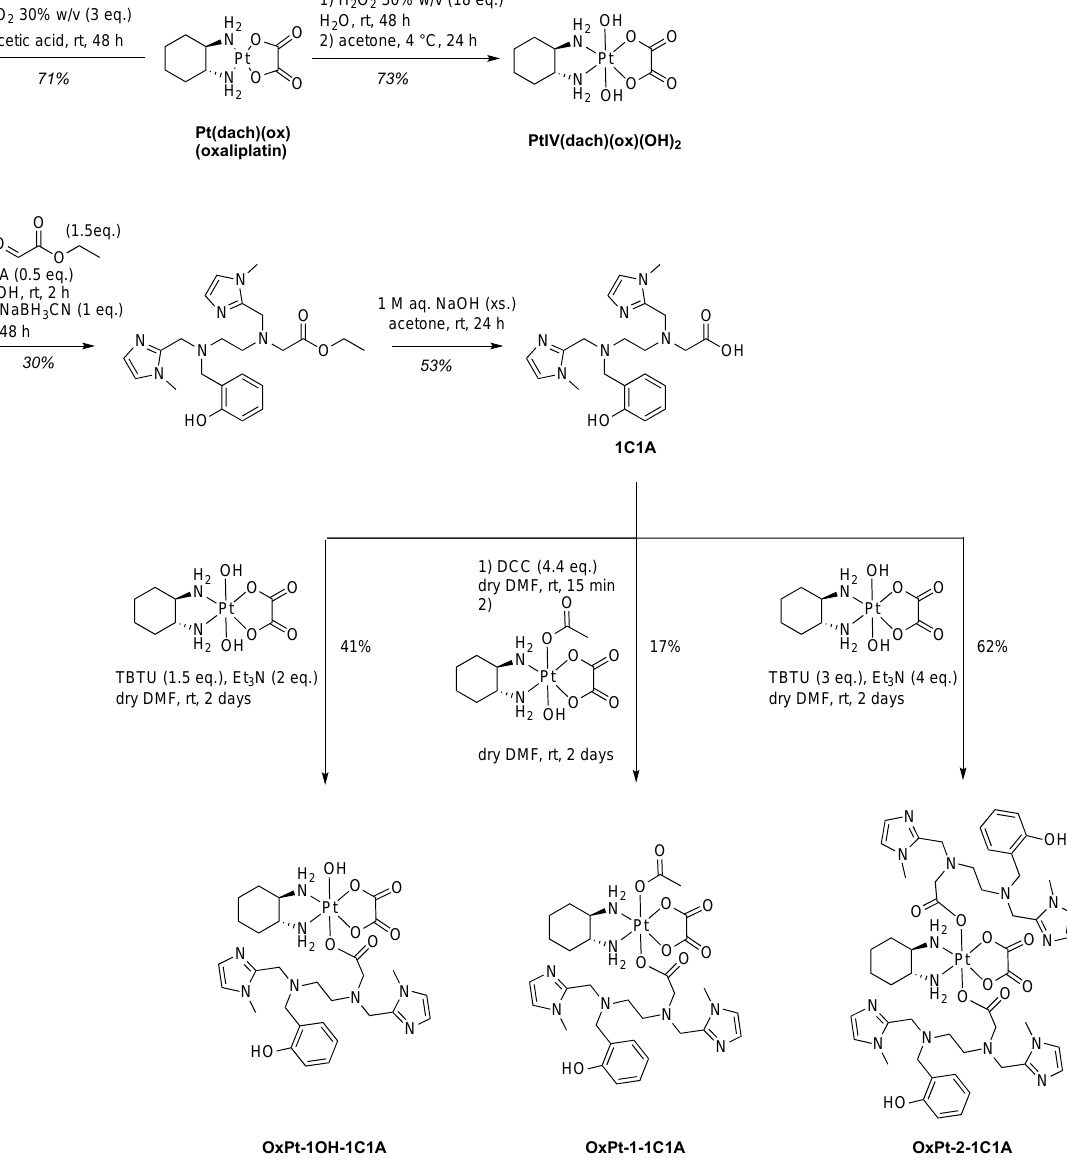
Scheme 1. Synthesis of the 1C1A ligand and the three Pt(IV) conjugates before Mn coordination, which is performed in